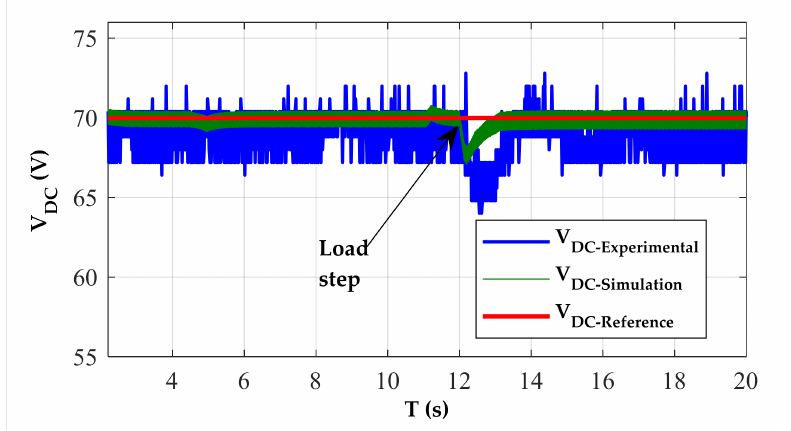
Figure 15. SRG operation in self-exited mode under variable load, at w = 600 rpm and V DC-ref = 70 V.